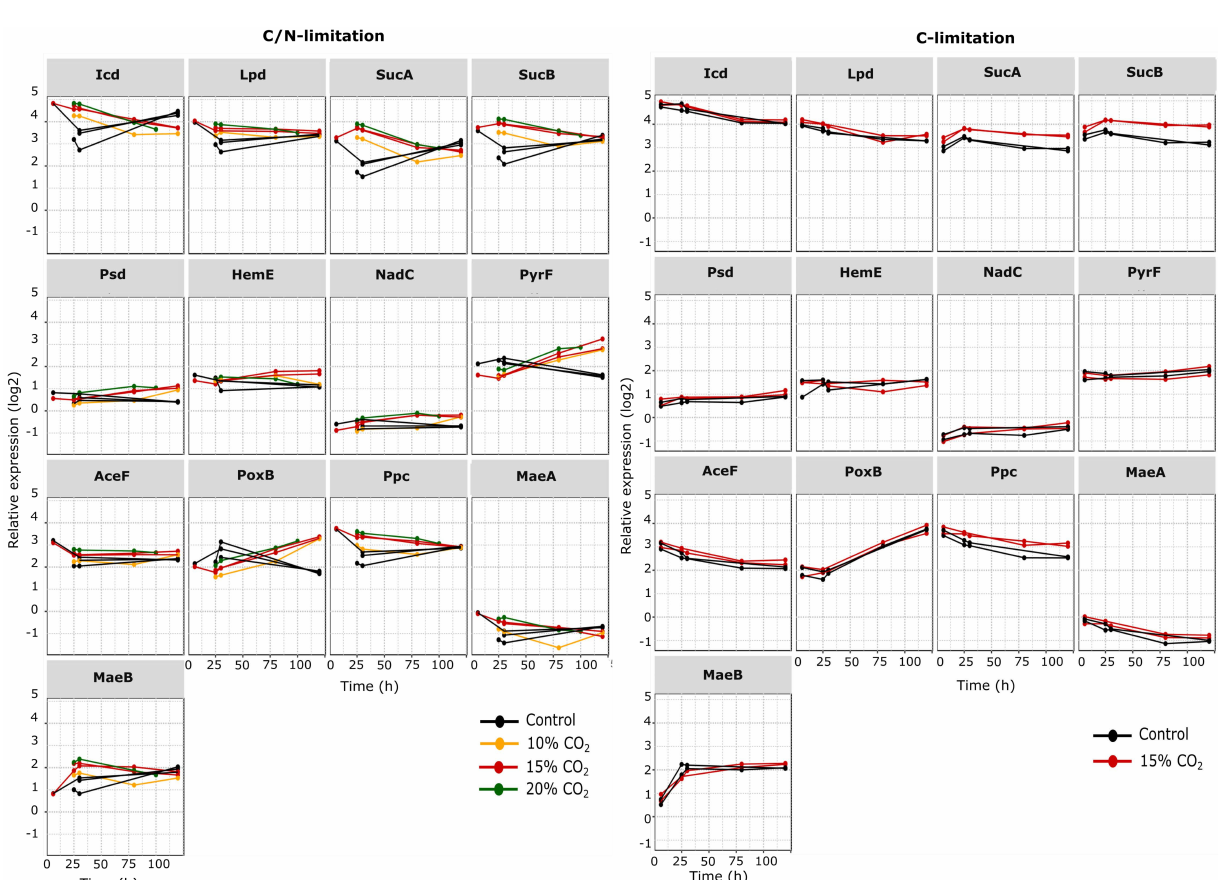
Figure A2. Changes in expression level of selected proteins involved in carboxylation and decarboxy- lation reactions. Y -axis = relative expression in log2, X -axis = fermentation age after feed start in